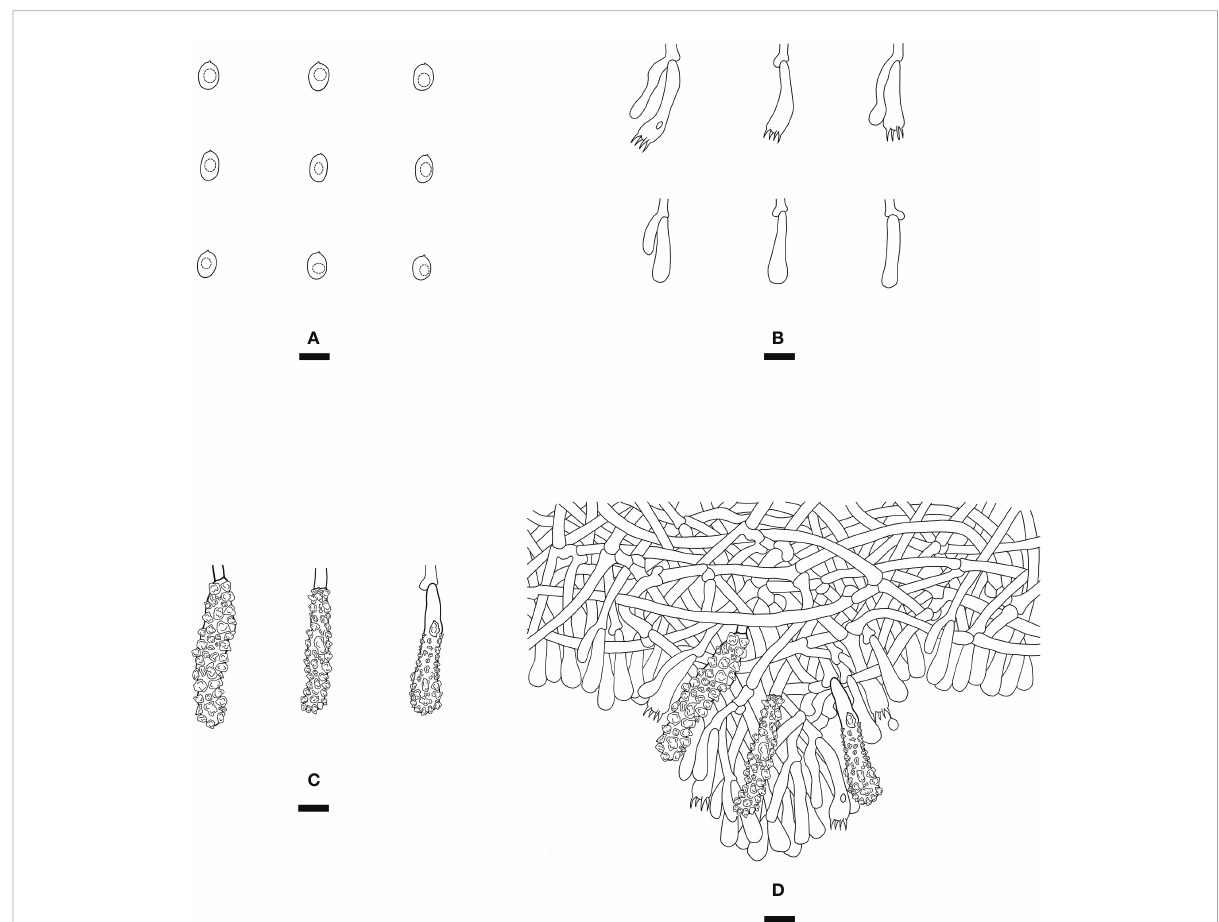
FIGURE 6 Microscopic structures of Steccherinum punctatum (drawn from the holotype). (A) Basidiospores. (B) Basidia and basidioles. (C) Skeletocystidia. (D) A section of hymenium. Bars: (A) 5 µm; (B – D) 10